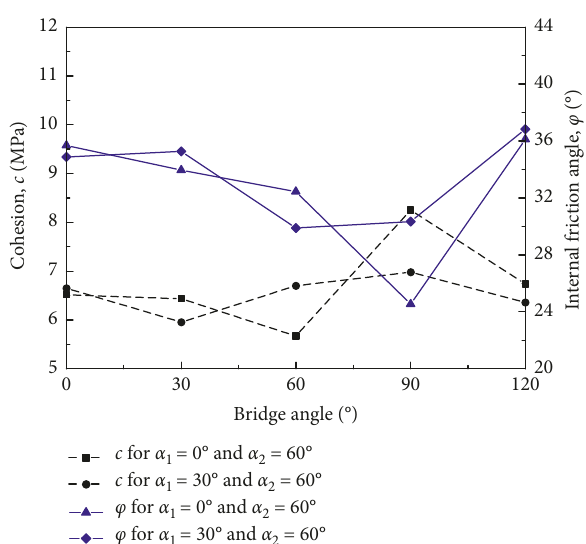
Figure 14: Shear parameters of the specimens 20-0-60- β and 20- 30-60- β having different bridge